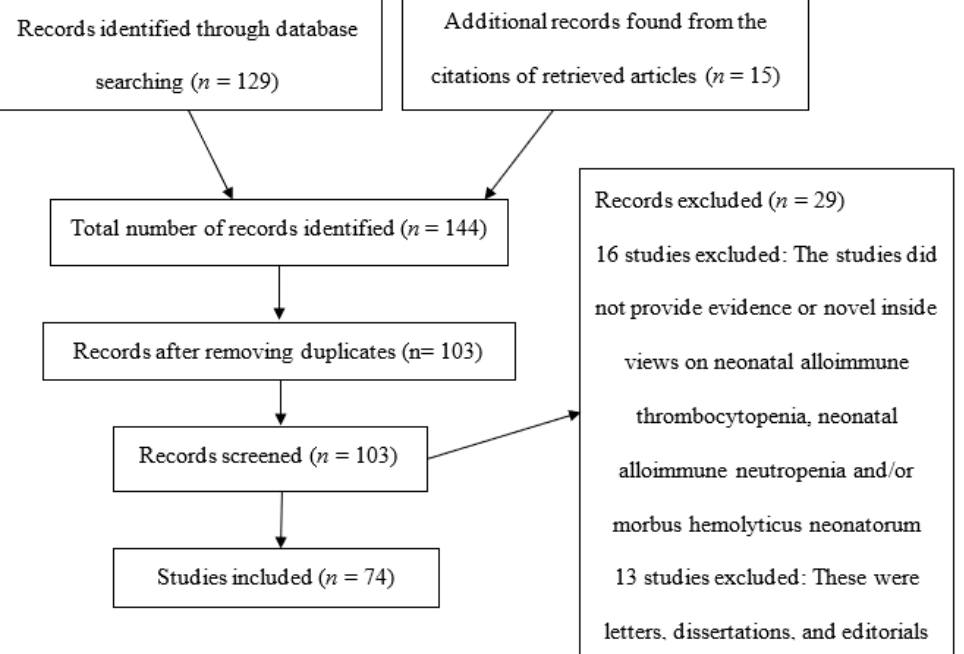
Figure 1. PRISMA flow diagram